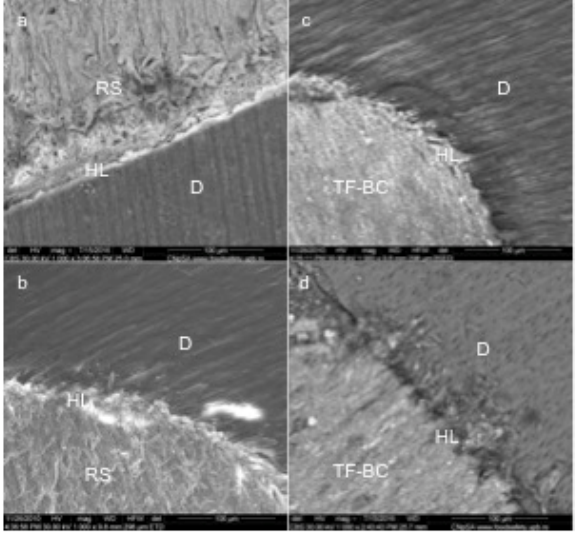
Figure 3. Representative SEM images of commercial sealers (magnification 1000X): Real Seal ( a , b ); TotalFill BC ( c , d ); RS- RealSeal, TF-BC- TotalFill BC, HL-hybrid layer, D-dentin.